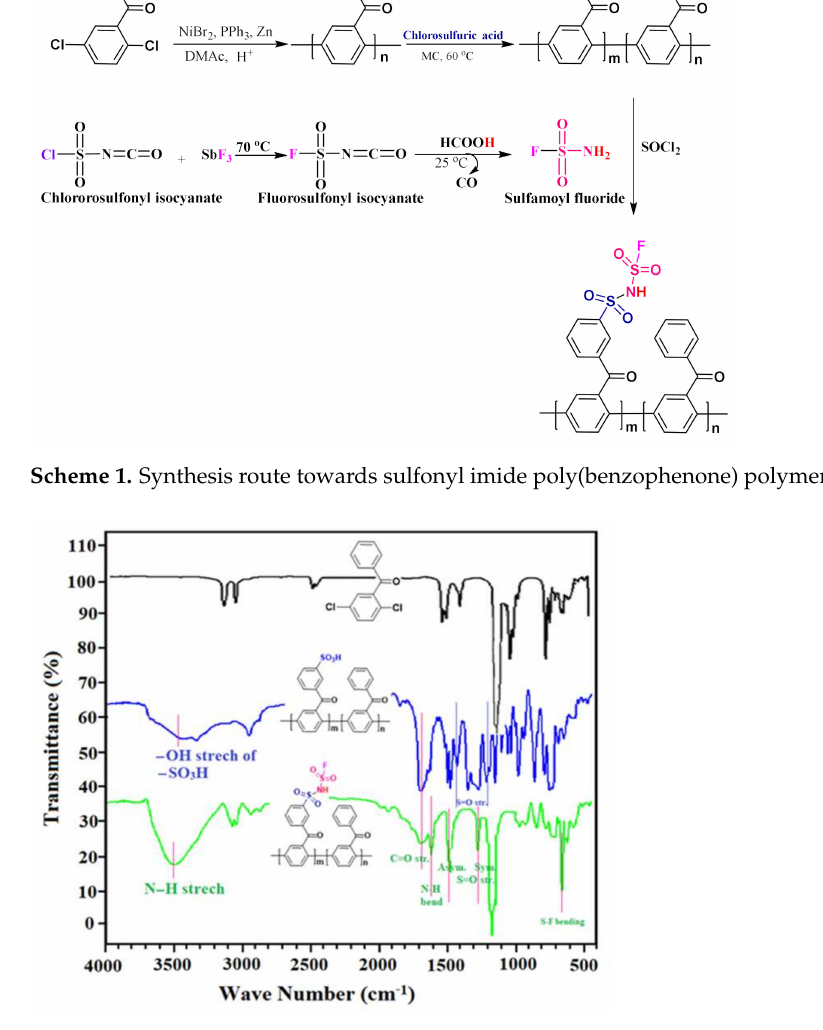
Figure 1. FT-IR spectra of PBP, S-PBP and SI-PBP.